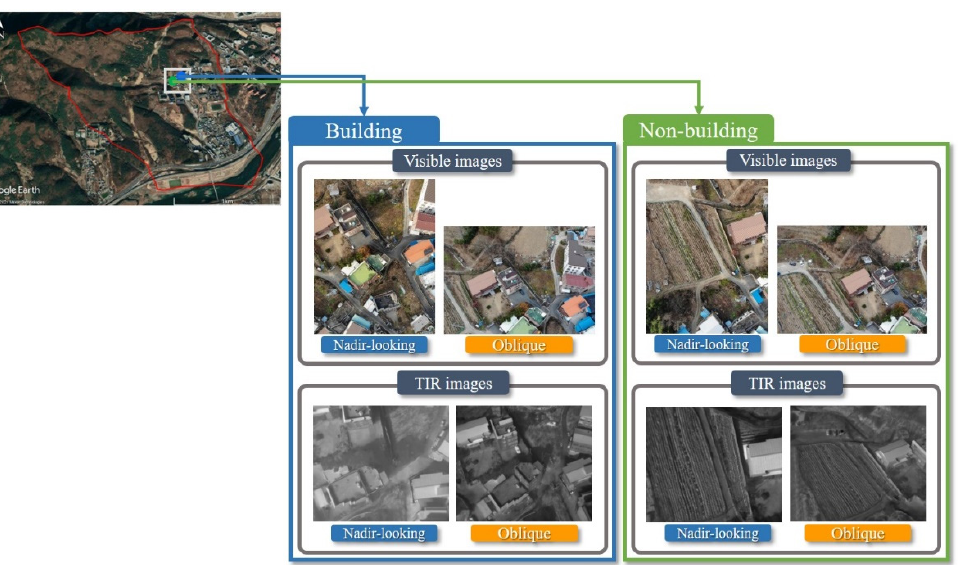
Figure 6. Classification of building and non-building types for obtained images (visible nadir-looking, visible oblique, TIR nadir-looking, and TIR oblique) on Google Maps.